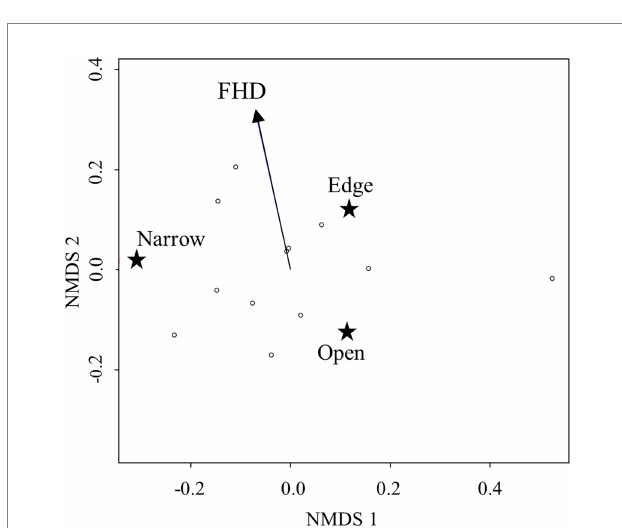
FIGURE 6 NMDS ordination plot showing the 12 dry grassland plots in k = 2 dimensions. Placement of plots is based on Bray–Curtis dissimilarity of the activity compositions of functional bat guilds (indicated by stars). Environmental fitting was used to find explanatory variables for differences in guild composition. The significant variable (FHD) is represented as a vector.